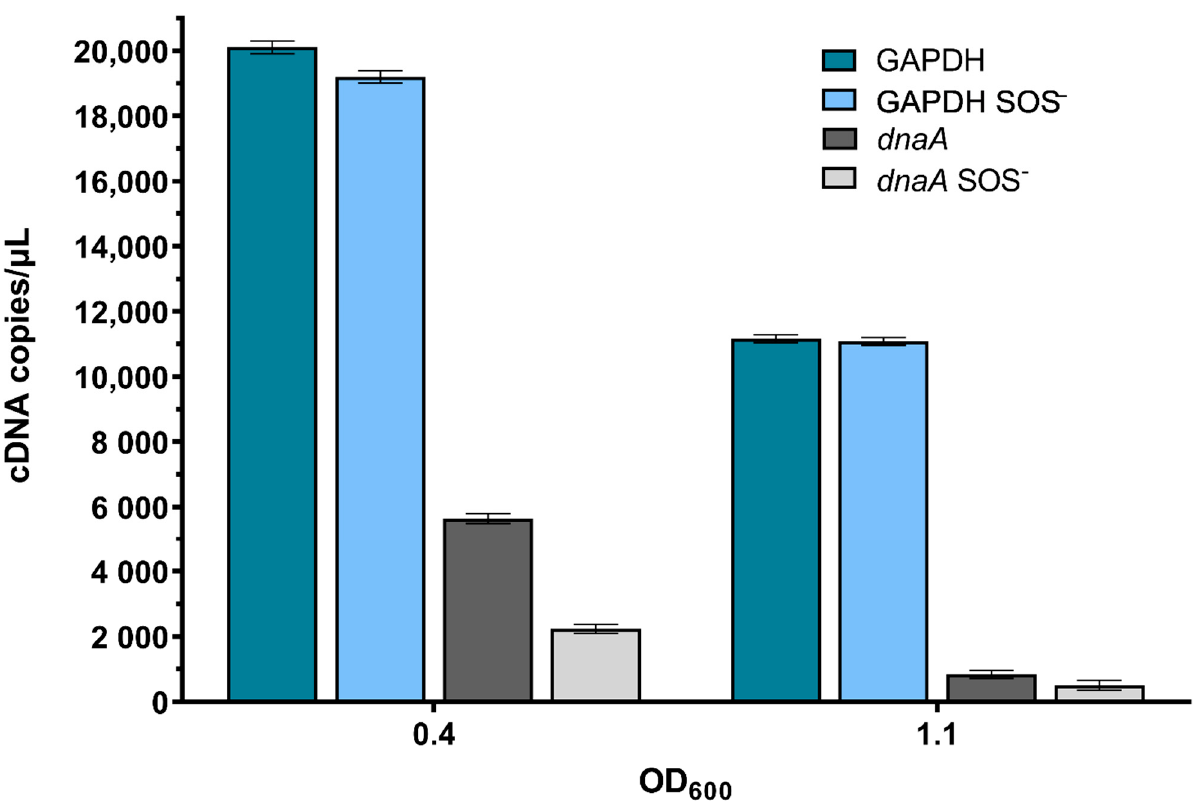
Figure 4. Absolute quantification of the GAPDH and dnaA genes’ transcripts during growth of wild-type and lexA3 (SOS − ) mutant bacteria in LB medium at 37 ◦ C. Measurements were taken at mid-exponential growth phase (OD 600 ~0.4) and early stationary growth phase (OD 600 ~1.1). Three independent ddPCR experiments at three different concentrations gave the same relative results. Error bars represent Poisson confidence interval at a 95% level.